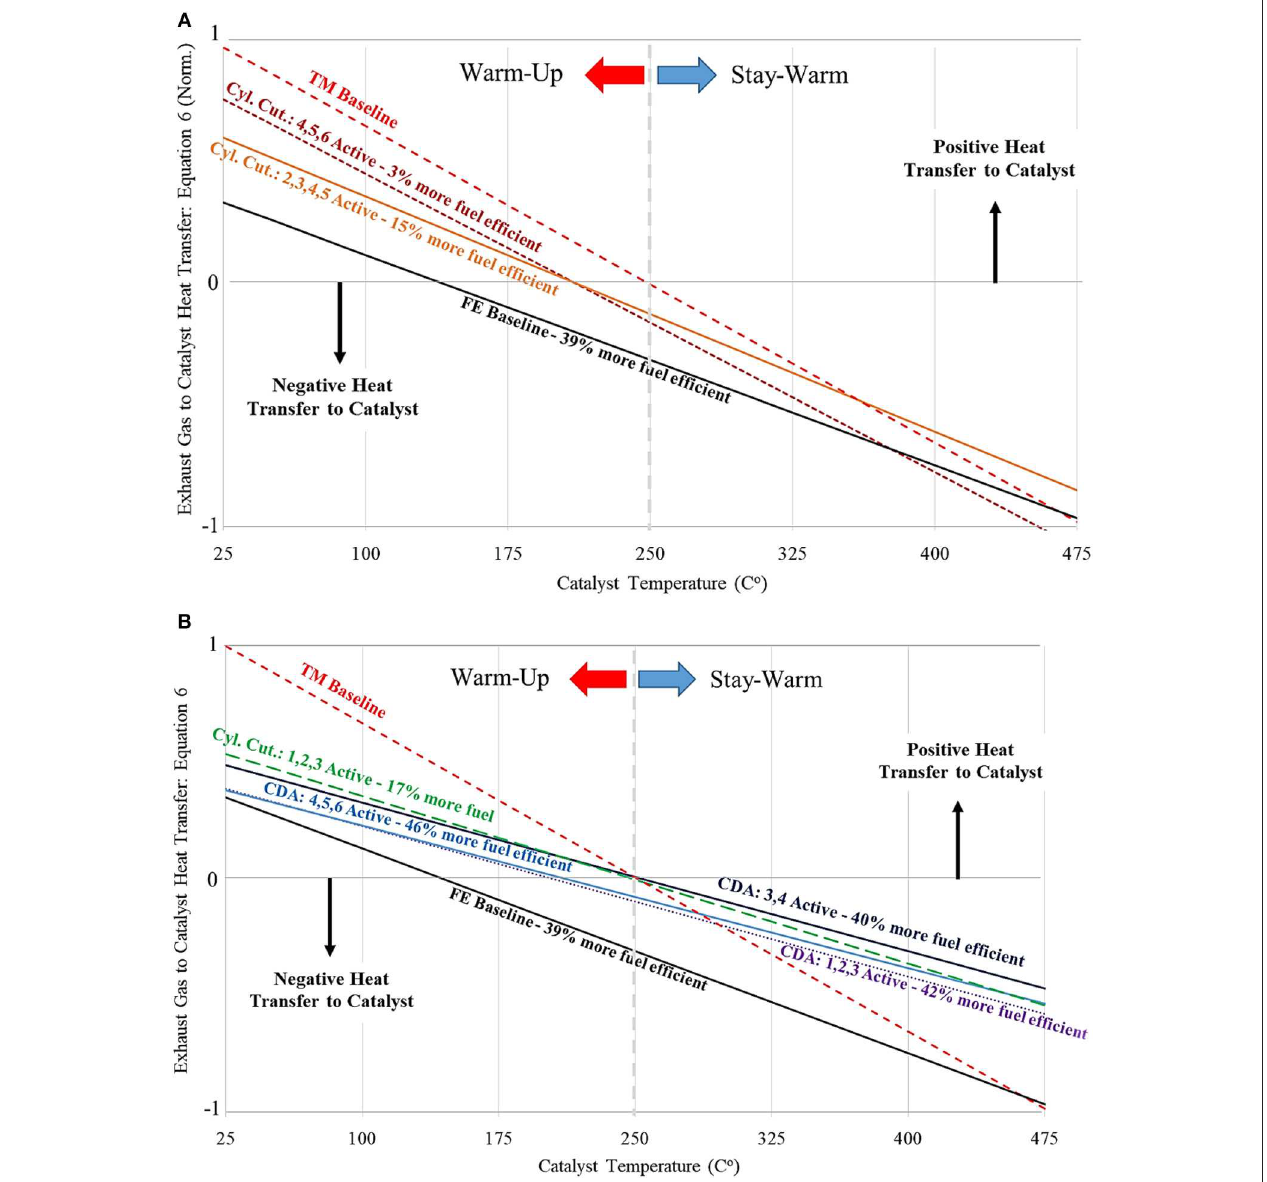
FIGURE 11 | Heat transfer rate plots, where the exhaust flow corresponds to the steepness of the slope and the crossing of the zero heat transfer rate axis represents the TOT. (A) Warm-up heat transfer rates require higher exhaust flows (i.e., steeper slopes) and generally high TOTs. (B) Stay-Warm heat transfer rates require lower exhaust flows (i.e., gradual slopes) and generally high